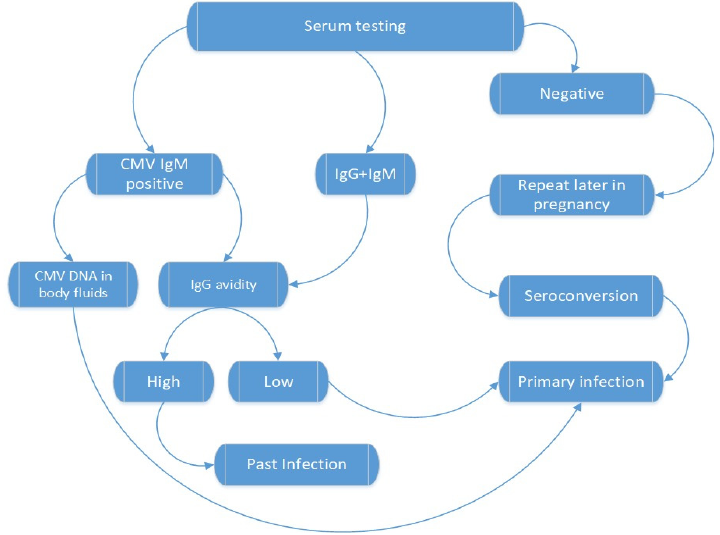
Figure 1. Maternal diagnosis of CMV infection [4].